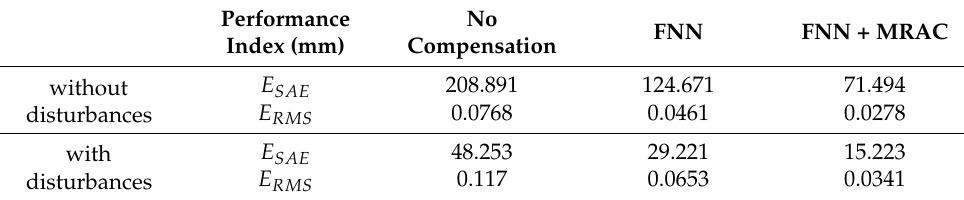
Table 4. Synchronous performance under high-frequency commands.